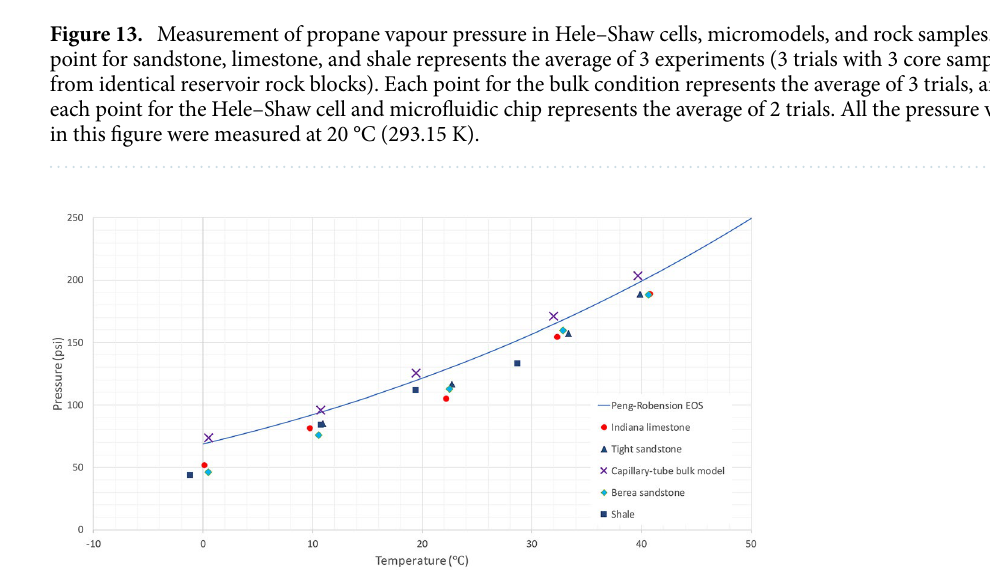
Figure 14. Measurement of vapour pressure in Berea sandstone, Indiana limestone, tight sandstone, and shale at various system temperatures. Each point represents the average of 3 experiments (3 trials with 3 core samples from identical reservoir rock blocks). Each point for the bulk condition represents the average of 3